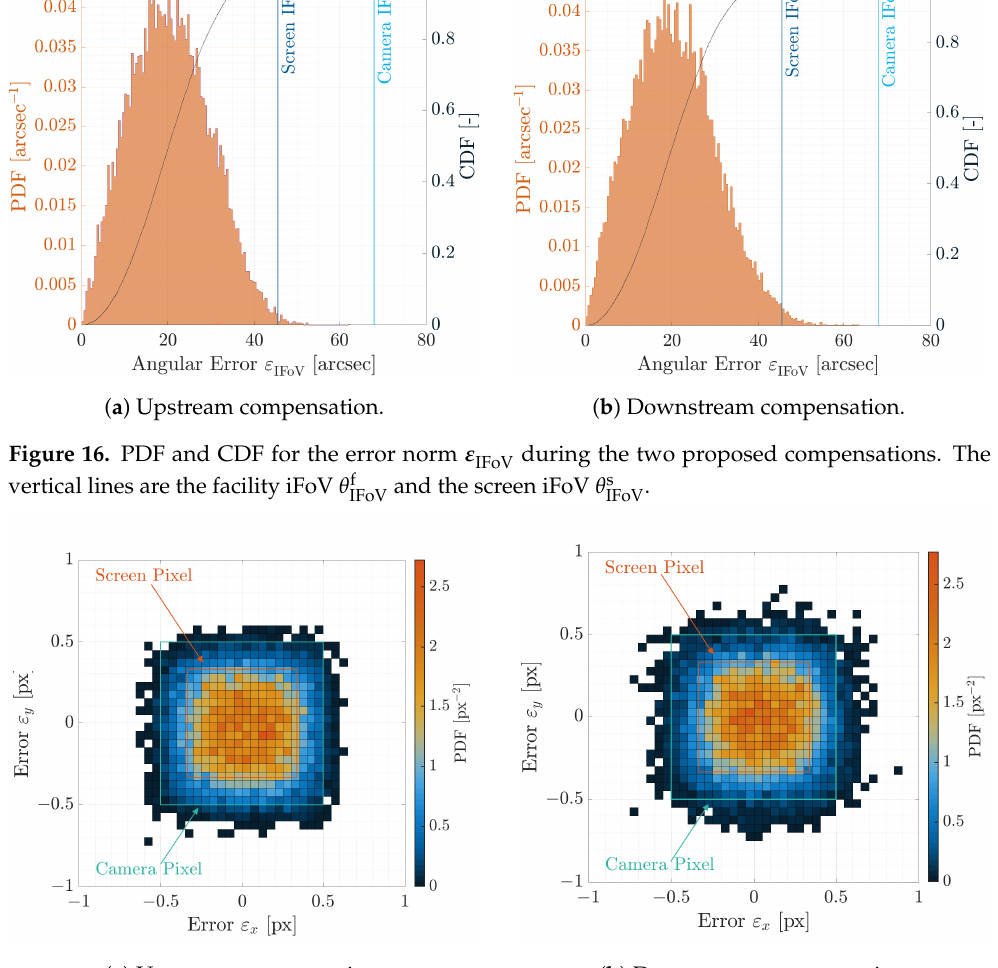
(cid:0) (cid:1) T ε x , ε y during the two proposed compensations.